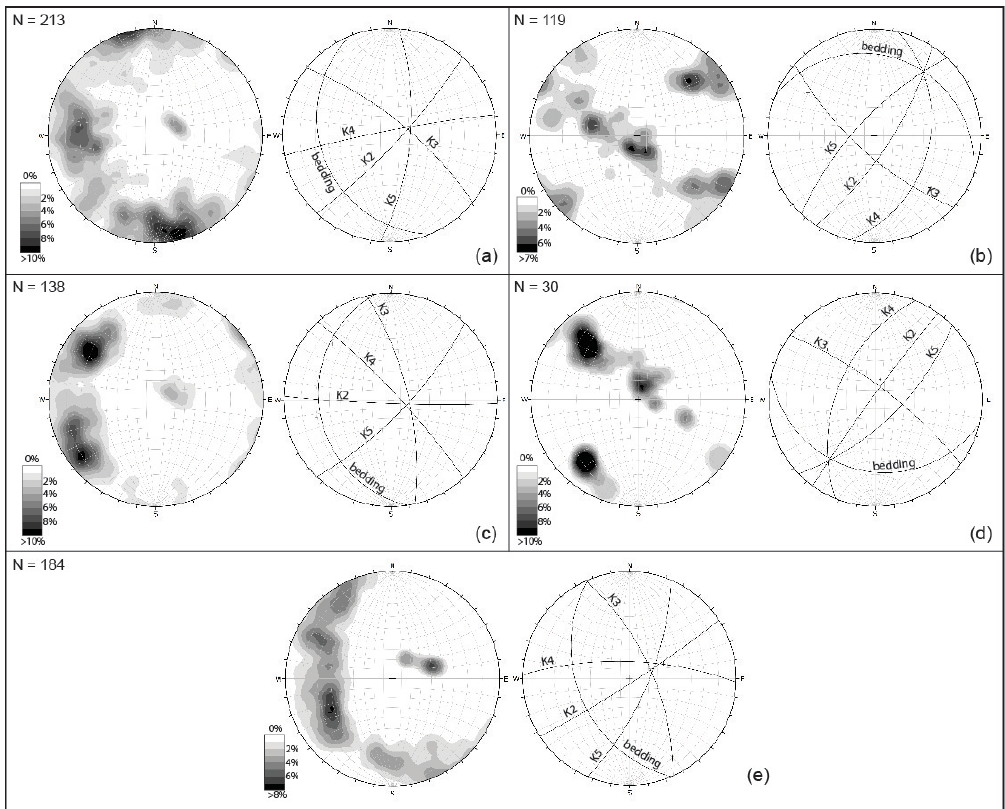
Figure 11. Contour plot of poles (equal area, lower hemisphere, per 1% area) and cyclographic projection of the mean planes (equal angle, lower hemisphere) of bedding and fractures of limbs 0 ( a ), 1 ( b ), 2 ( c ), 3 ( d ) and 4 ( e ).